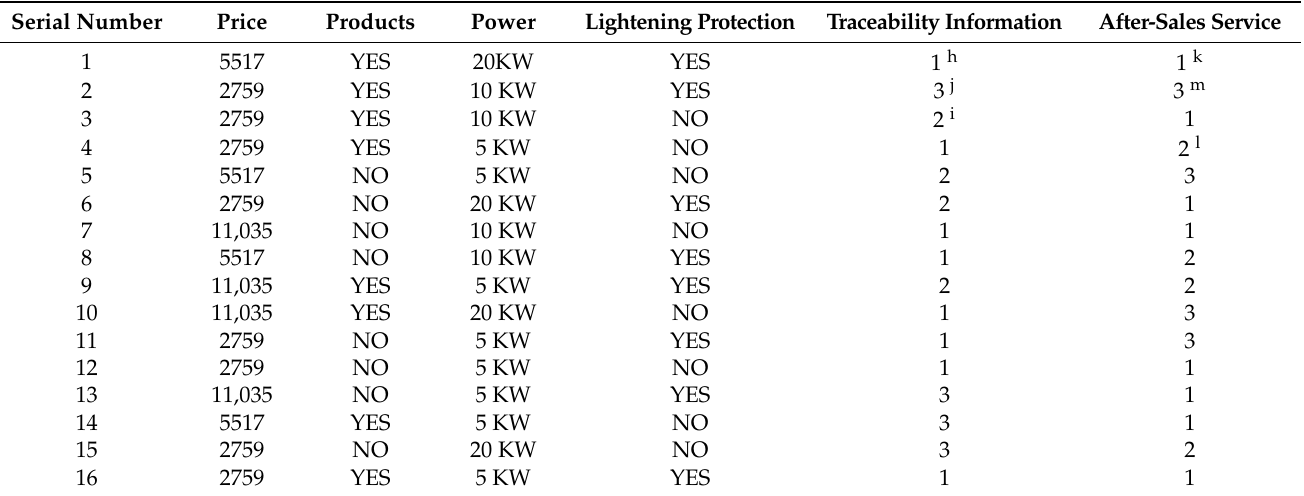
Table 2. Orthogonal test